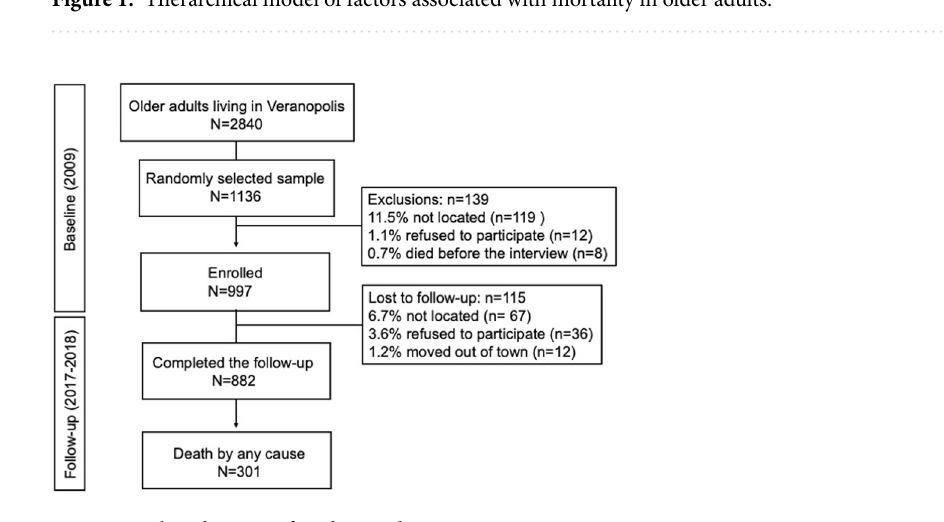
Figure 2. Flow diagram of study